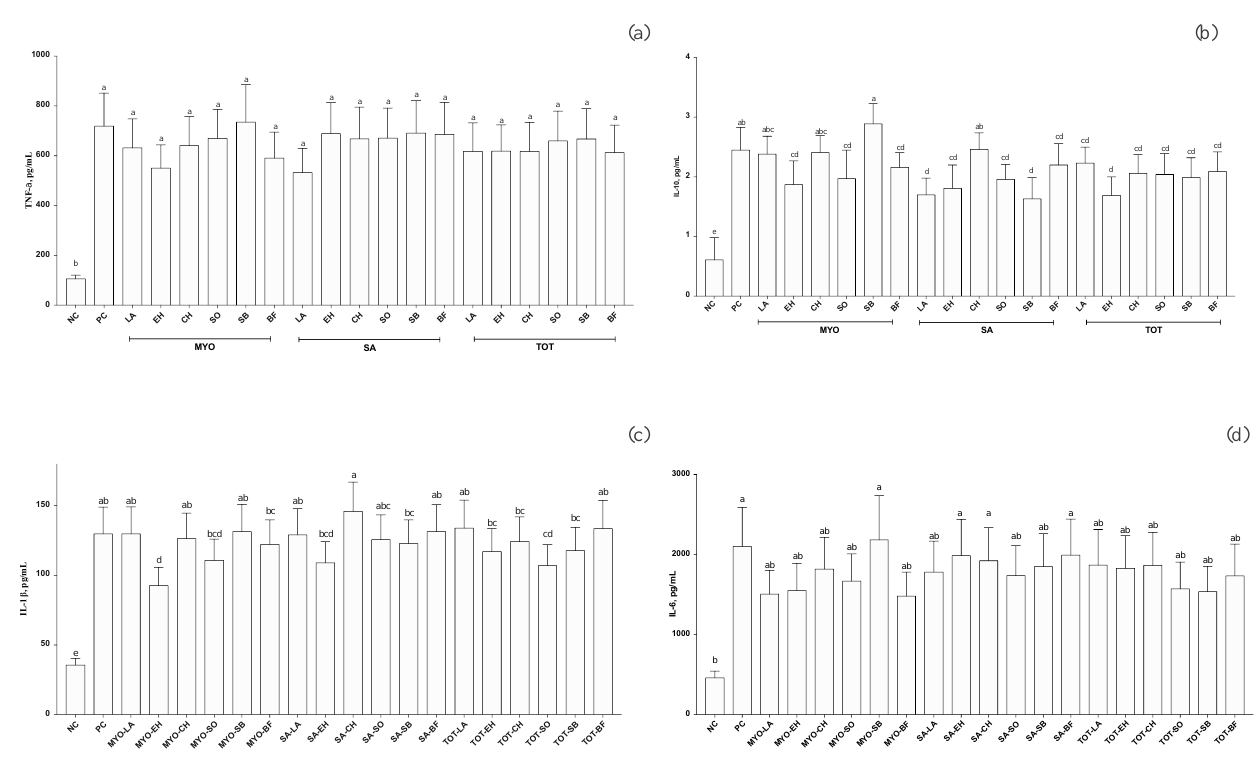
Figure 6. Cytokine pattern in terms of ( a ) TNF- α , ( b ) IL-10, ( c ) IL-1 β, and ( d ) IL-6 (means ± SE; pg/mL) averaged among different classes (LL-EC = group of children with epilepsy with similar levels of cytokines to those of control children; ML-EC = group of children with epilepsy with cytokine levels at least 2-fold higher (medium levels) than those of control children; HL-EC = group of children with epilepsy with cytokine levels at least 8-fold higher (high levels) than those of control children) and based on in vitro treatments (NC = negative control, PC = positive control, SA-LA = sarcoplasmic protein fractions from lamb meat, MYO-LA = myofibrillar protein fraction from lamb meat, TOT-LA = total protein fractions from lamb meat, SA-CH = sarcoplasmic protein fractions from chicken meat, MYO-CH = myofibrillar protein fractions from chicken meat, TOT-CH = total protein fractions from chicken meat, SA-BF = sarcoplasmic protein fractions from beef, MYO-BF = myofibrillar protein fractions from beef, TOT-BF = total protein fractions from beef, SA-EH = sarcoplasmic protein fractions from European hake fish meat, MYO-EH = myofibrillar protein fractions from European hake fish meat, TOT-EH = total protein fractions from European hake fish meat, SA-SO = sarcoplasmic protein fractions from sole fish meat, MYO-SO = myofibrillar protein fractions from sole fish meat, TOT-SO = total protein fractions from sole fish meat, SA-SB = sarcoplasmic protein fractions from sea bass, MYO-SB = myofibrillar protein fractions from sea bass, and TOT-SB = total protein fractions from sea bass. a–d Means with different letters are significantly different, p <